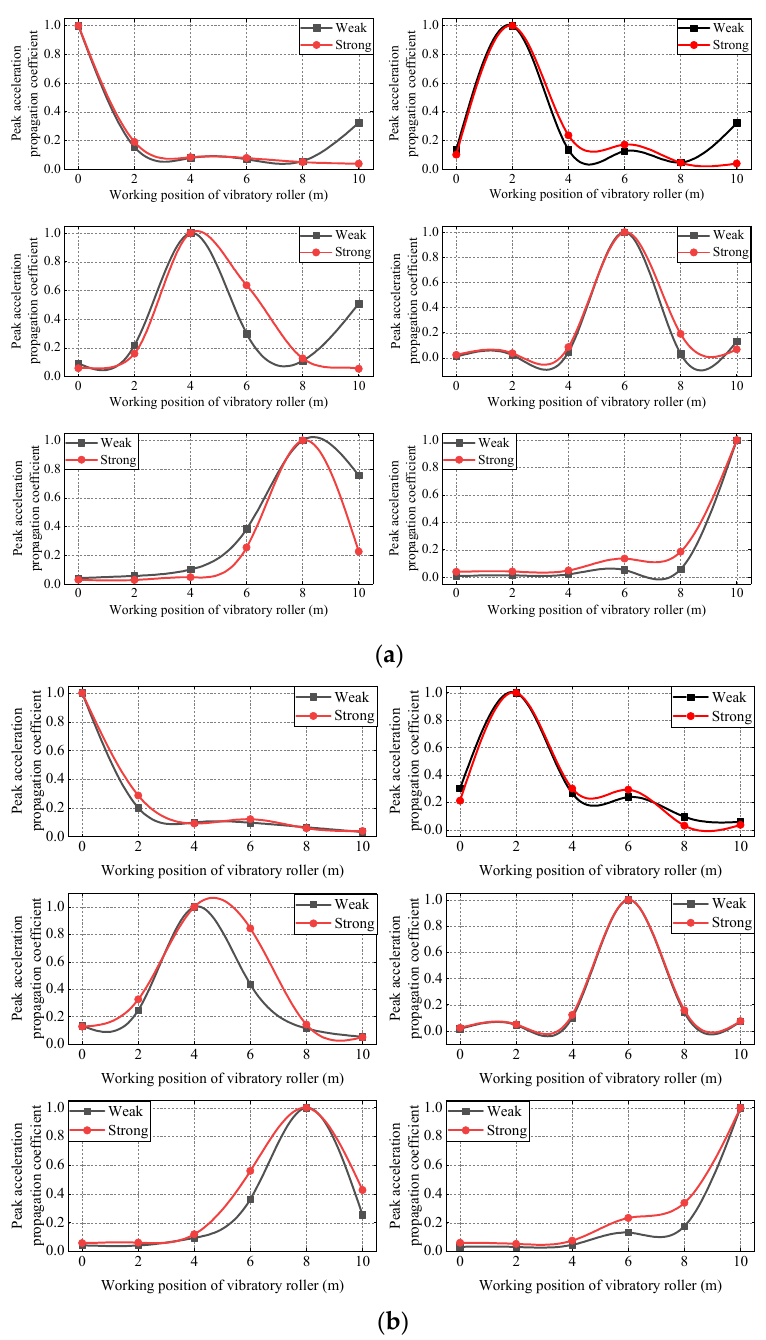
Figure 10. Propagation coefficient of peak acceleration under different amplitudes of vibratory roller. ( a ) Propagation coefficient of peak acceleration under uncompacted state. ( b ) Propagation coefficient of peak acceleration under compacted state.